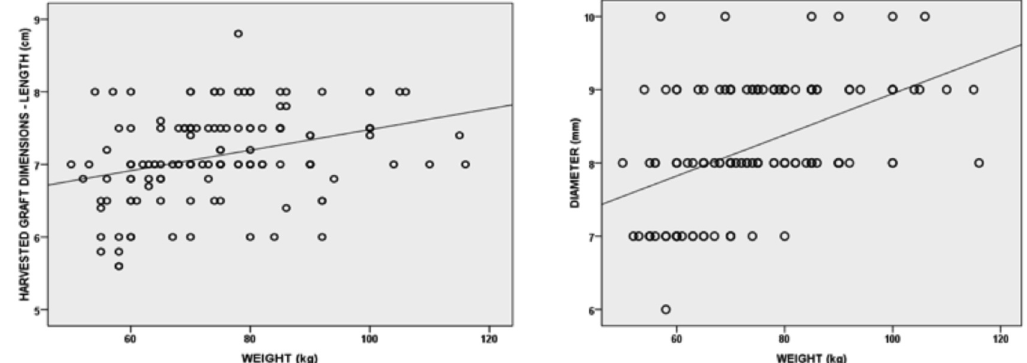
Graph showing positive correlation between patients weight and graft length (R=0.33, R2=0.11, p value <0.0001) and graft Fig. 3: diameter (R=0.47, R2= 0.22, p value